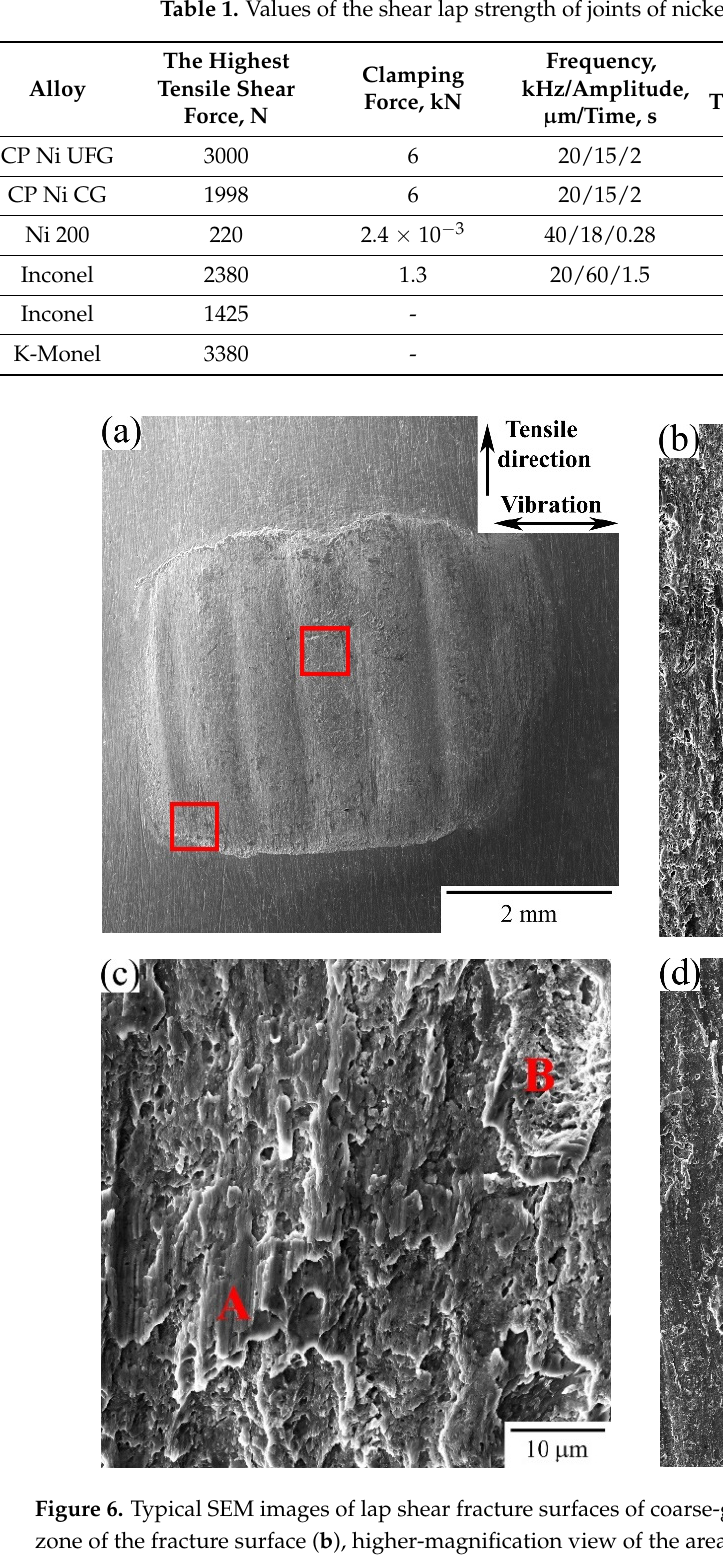
Table 1. Values of the shear lap strength of joints of nickel and its alloys processed by spot USW.